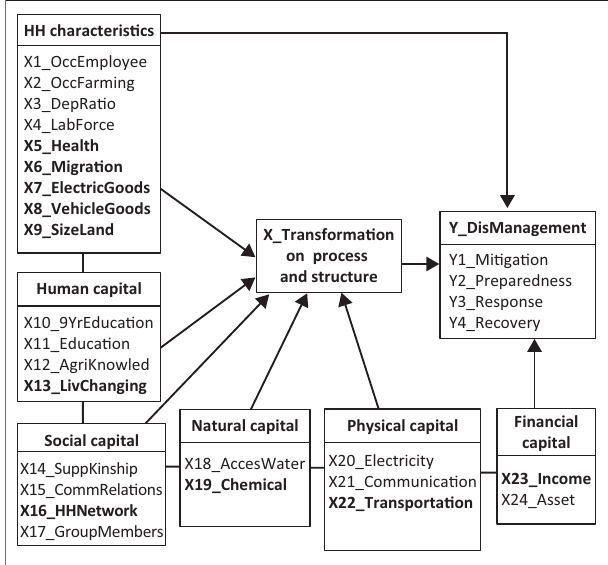
FIGURE 2: Conceptual framework before path